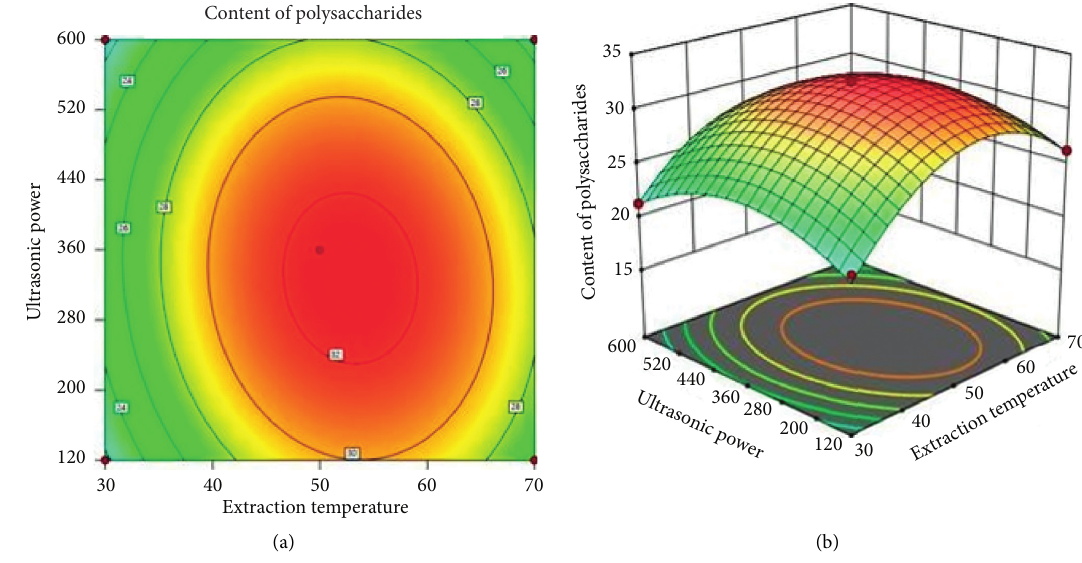
Figure 6: Simultaneous effect of extraction temperature and ultrasonic power on the content of polysaccharides.